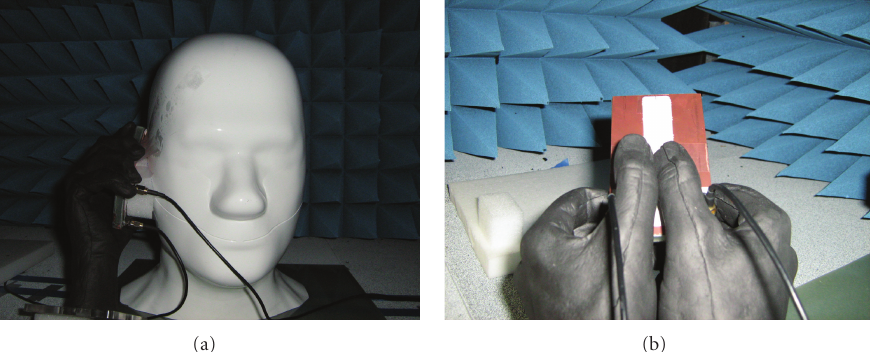
Figure 3: Lab measurements’ set-up for the MIMO design, (a) voice position with the handset, head, and the hand, and (b) two hands and handset in data